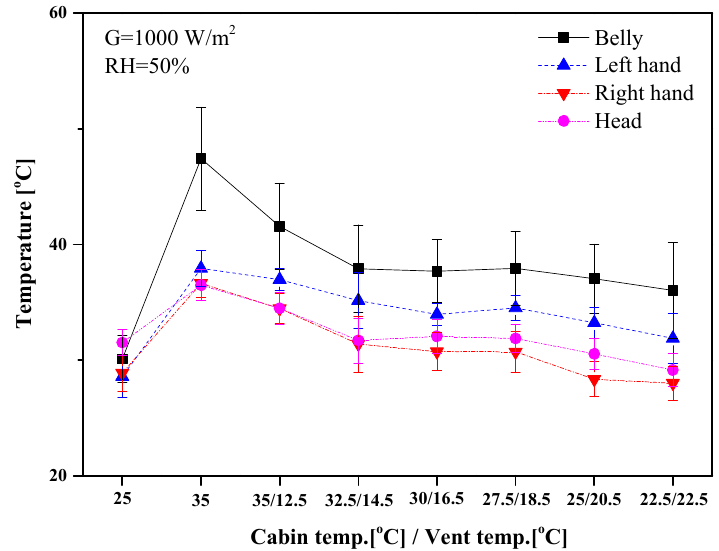
Figure 7. Variation of driver’s mean skin temperature in the cooling mode.